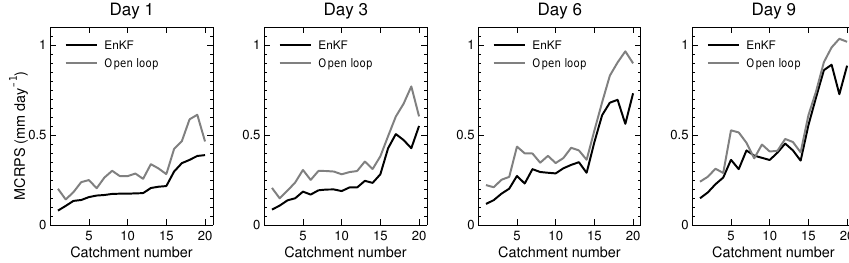
Figure 5. Comparison of open-loop and EnKF multimodel MCRPS sorted by increasing EnKF MCRPS (system E vs. G).